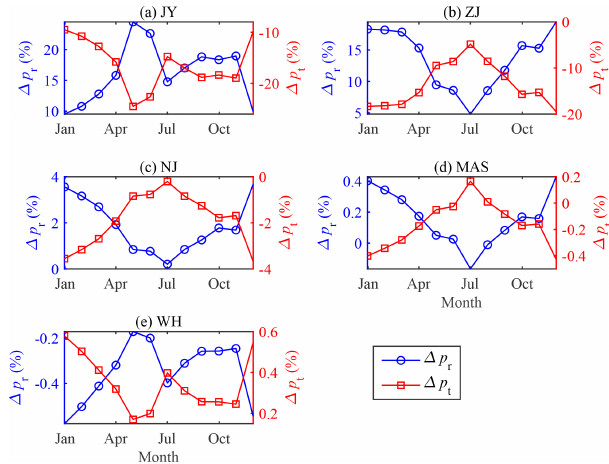
Figure 8. Alterations in variance contributions of riverine (cid:49)p r and tidal (cid:49)p t forcing at different gauging stations along the upper YRE: (a) Jiangyin (JY), (b) Zhenjiang (ZJ), (c) Nanjing (NJ), (d) Maan- shan (MAS), (e) Wuhu